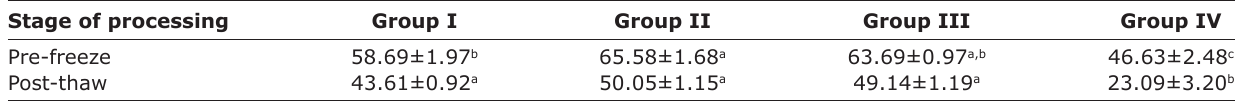
Values having different superscript differ significantly (p<0.05). Group I: Control; Group II: Supplemented with CLC @ 1 mg/120×10 6 spermatozoa; Group III: Supplemented with CLC @ 2 mg/120×10 6